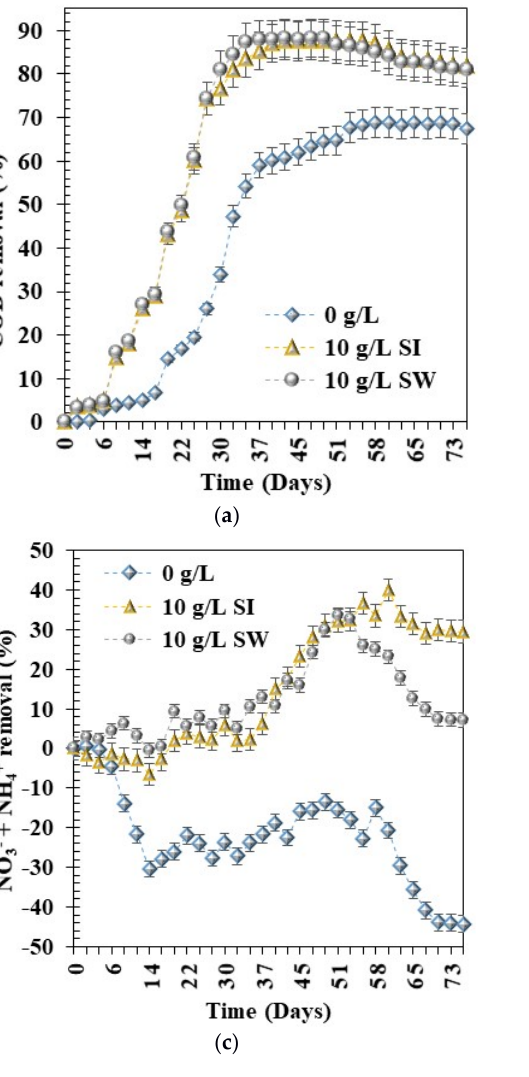
Figure 5. Comparison between SI and SW materials’ effect on pollutants removal ( a ) COD removal; ( b ) PO 4 3 − removal; ( c ) NO 3 − + NH 4 + removal; ( d ) pH variations. Fe 0 materials’ dosages were 0 g, 10 g/L SI, and 10 g/L SW; Systems’ temperature, T = 37 ± 0.5 °C. Comparison of the impact of SI and SW materials on the removal of nutrients as Statistical analysis shows negative relationships between the observed pollutants NO 3 − + NH 4+ is presented in Figure 5c. The results show that the minimum observed (COD, NO 3 − + NH 4 + , and PO 4 − 3 ) and total iron concentrations in Systems IV and NO 3 − + NH 4+ removal in all observations were relatively lower in the reference (System I) than in System IV or VII. Accordingly, compared to the reference, both SI and SW mate- rials improved the performance of the reactors in removing NO 3 − + NH 4+ . However, sta- tistically, there was no distinguishable difference in the observed NO 3 − + NH 4+ removal between 10 g/L SI reactor (M = 14.9%, SD = 15.7%) and 10 g/L SW reactor (M = 12.1%, SD = 9.8%), t (31) = 1.6, p > 0.01, two-tailed. Although Fe 0 significantly improved the removal of NO 3 − + NH 4+ as compared to the system without Fe 0 (Section 3.2.3), NO 3 − + NH 4+ was the least removed pollutant (among COD, NO 3 − + NH 4 + and PO 4 3 − ) regardless the type of